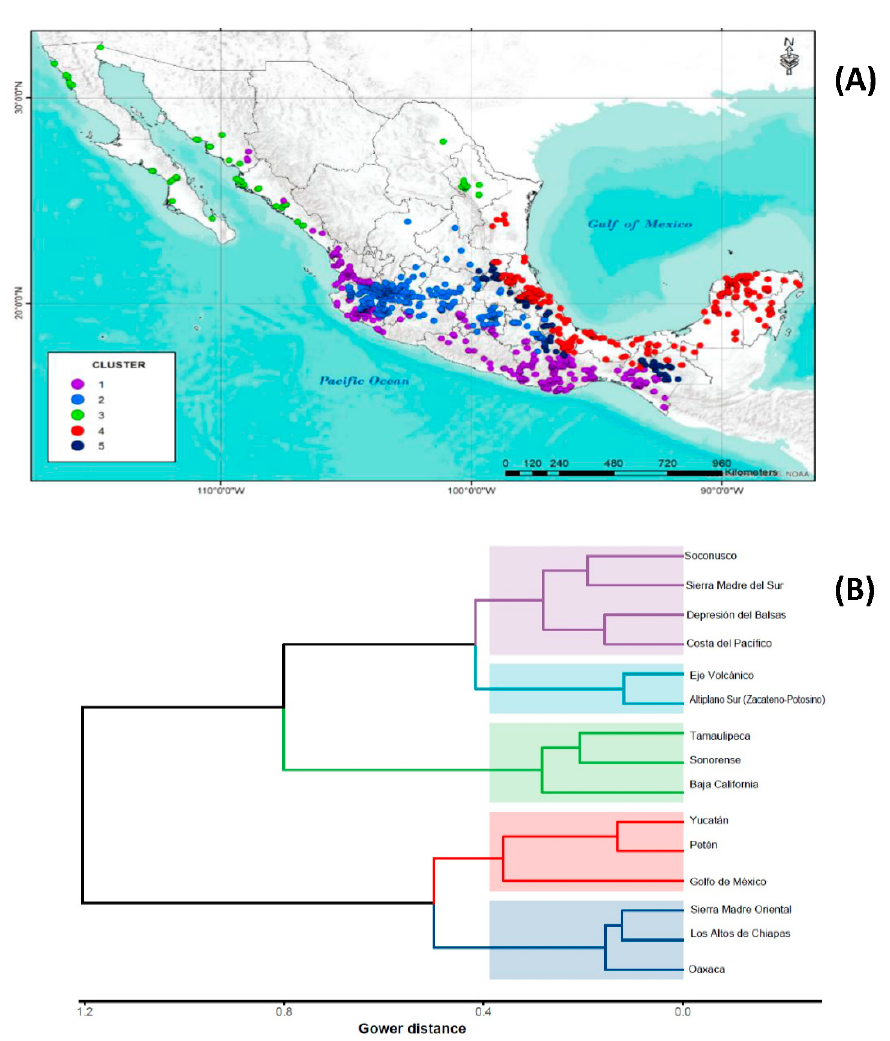
Figure 2. ( A ) Map with the geographical distribution of S. lycopersicum L. accessions in Mexico according to 5 clusters identified in CA. ( B ) Dendrogram with Gower distances and Ward’s clustering method.